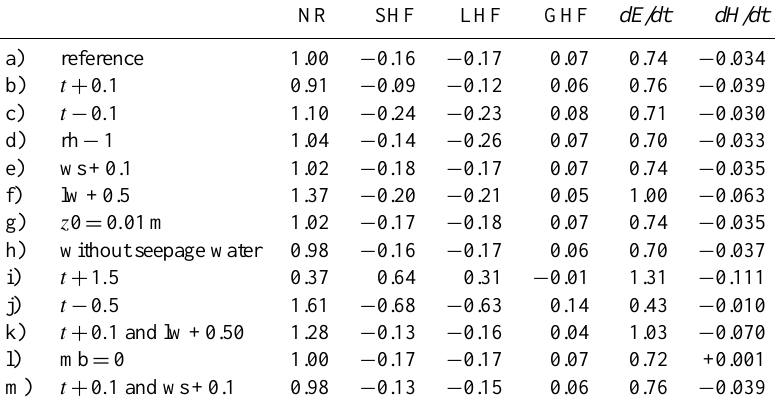
Table 2. Mean energy balance components (Wm − 2 ) for different model settings and resulting changes in ice thickness H (m).